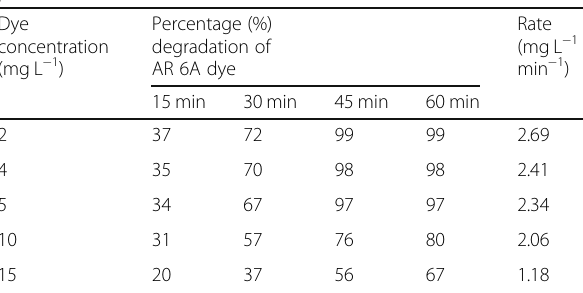
Table 7 Effect of the initial concentration of dye on the rate of degradation of AR 6A, at catalyst dosage of 100 mg L − 1 and pH = 6 Dye concentration (mg L − 1